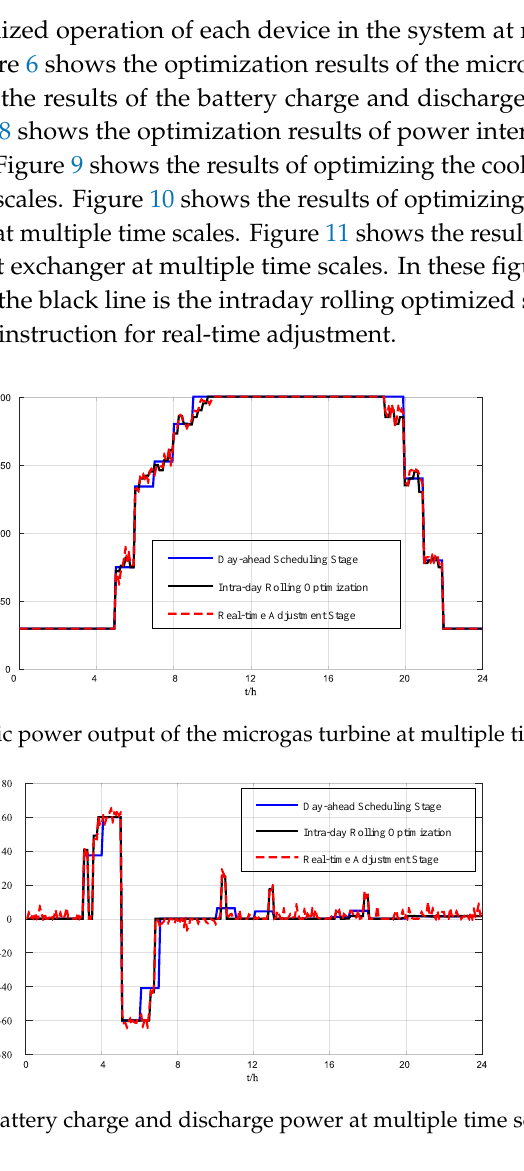
Figure 8. Interactions with the power grid at multiple time scales.